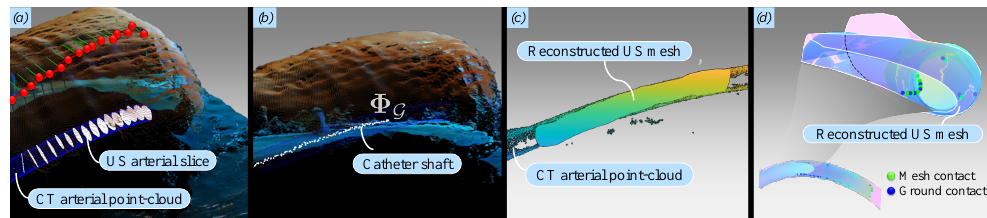
Figure 7. Multi-modal visualization results: ( a ) The point-cloud library (PCL) interface is used to visualize the porcine tissue surface, red projected surface points, the ultrasound (US) transducer orientation frames, and the reconstructed US slices (white); ( b ) visualization of the Fiber Bragg Grating (FBG)-embedded catheter ( Φ ) inside the artificial artery; ( c ) the reconstructed US artery G is reproduced as a surface mesh comprising centroids and boundaries. Visual inspection of the reconstruction of the artificial artery yields commendatory results when compared to the Computed Tomography (CT) point-cloud; ( d ) Potential contact points between the catheter shaft and the artificial artery inner wall are estimated using an approximative method to threshold their Euclidean distances. For the current catheter (with a radius of 1 mm), this threshold is chosen as 1.25 mm. Please refer to the accompanying video (https://www.dropbox.com/s/643q13ixv52oavn/ARMM_Multimodal_ Systems.mp4?dl=0) to view this